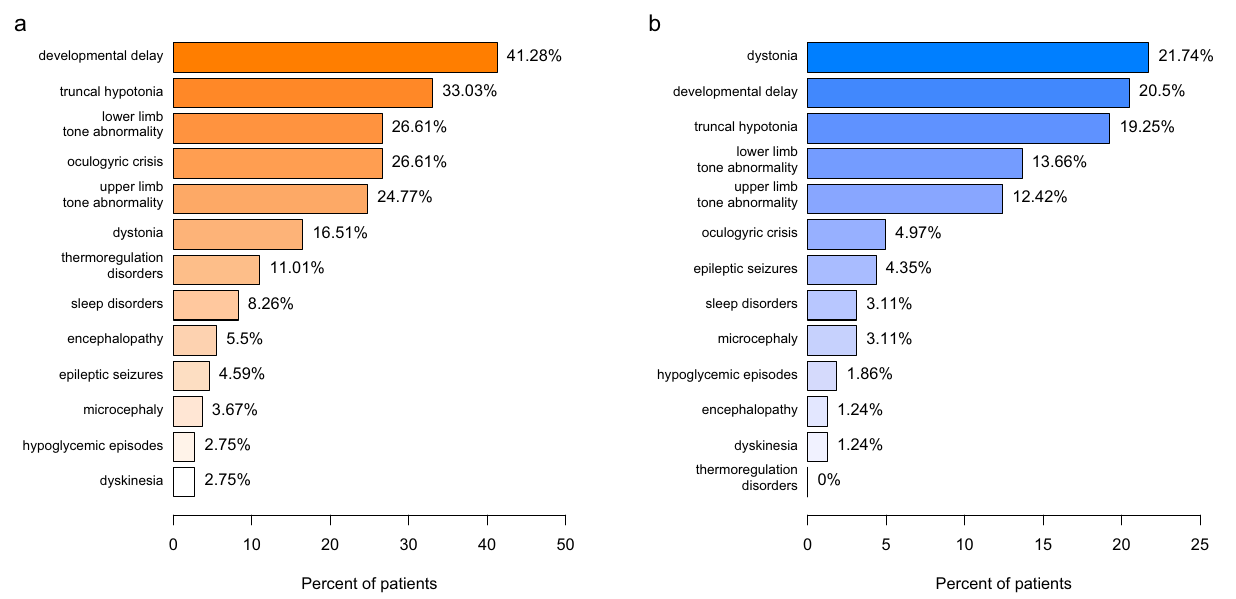
Fig. 2 Symptoms at disease onset. Initial symptoms in primary disorders of biogenic amine metabolism ( a ) and BH de fi ciencies ( b ), age independent